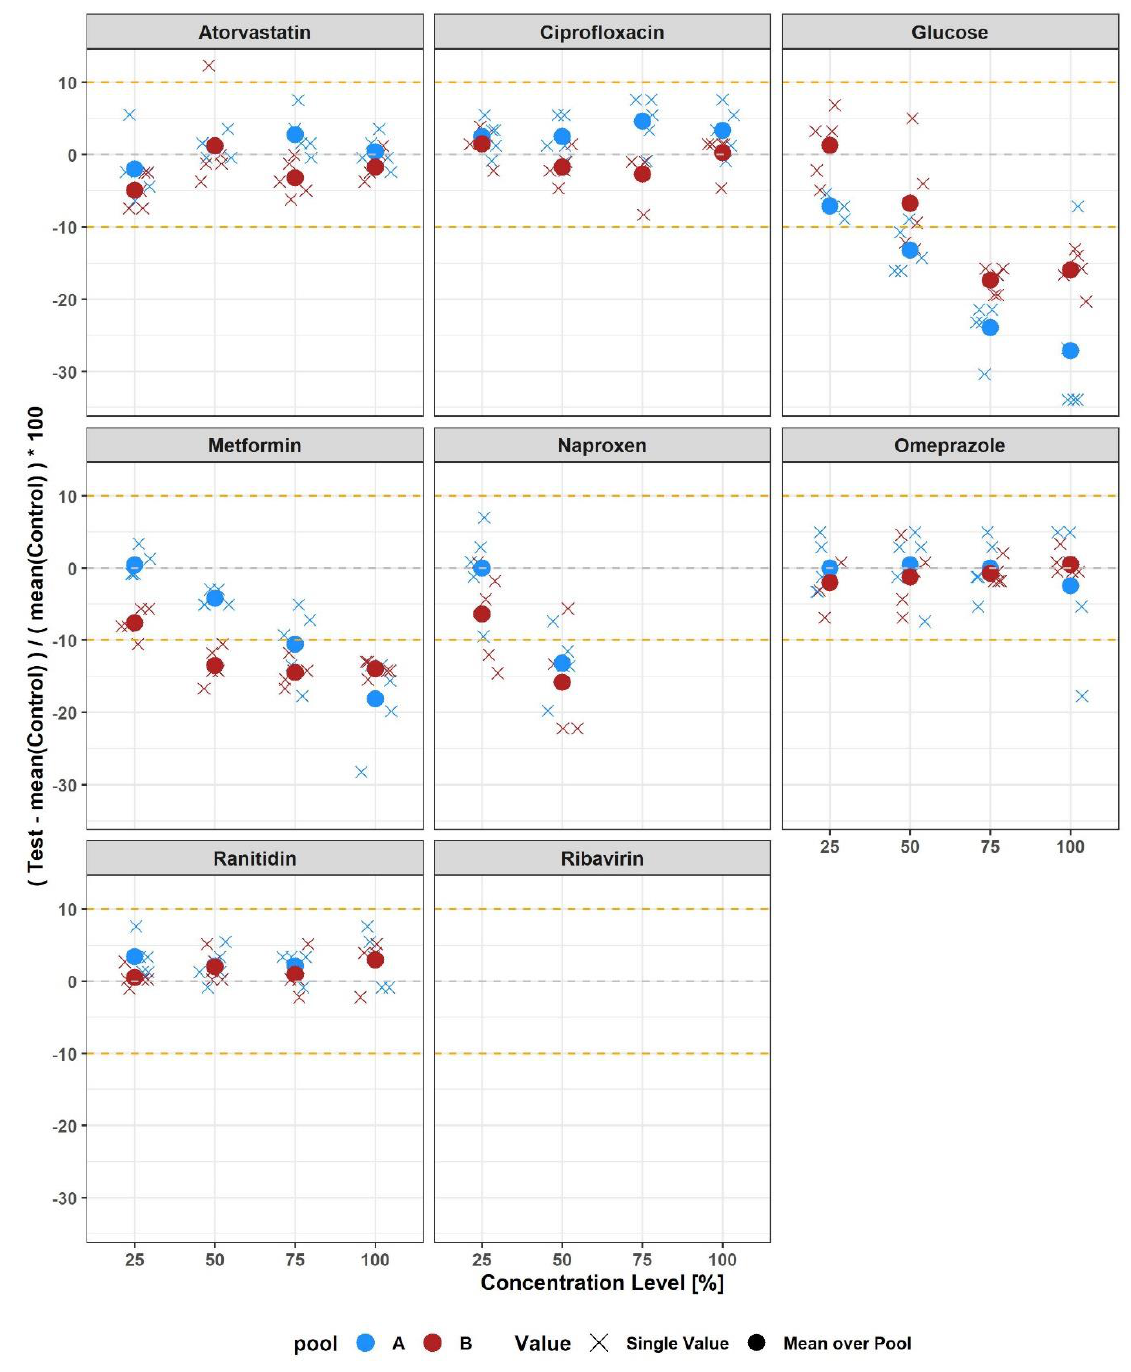
Figure 4. Dose−response interference experiments. Strip plots showing relative biases of GFR NMR in serum pools (A: “low”, B: “high”, as defined in Table 4) spiked with increasing concentrations (0%, 25%, 50%, 75% and 100%) of the indicated potentially interfering substances (100% corresponding to the test concentration displayed in Table S1). Glucose > 13.9 mmol/L and metformin > 23.2 μmol/L caused falsely low GFR NMR results, naproxen > 0.39 mmol/L caused falsely low or missing results at >0.78 mmol/L, and ribavirin ≥ 210 mg/L caused missing results. Interference suspected in the screening step (Table 4) was not confirmed in the dose-response assay for atorvastatin, ciprofloxacin, omeprazole and ranitidin.